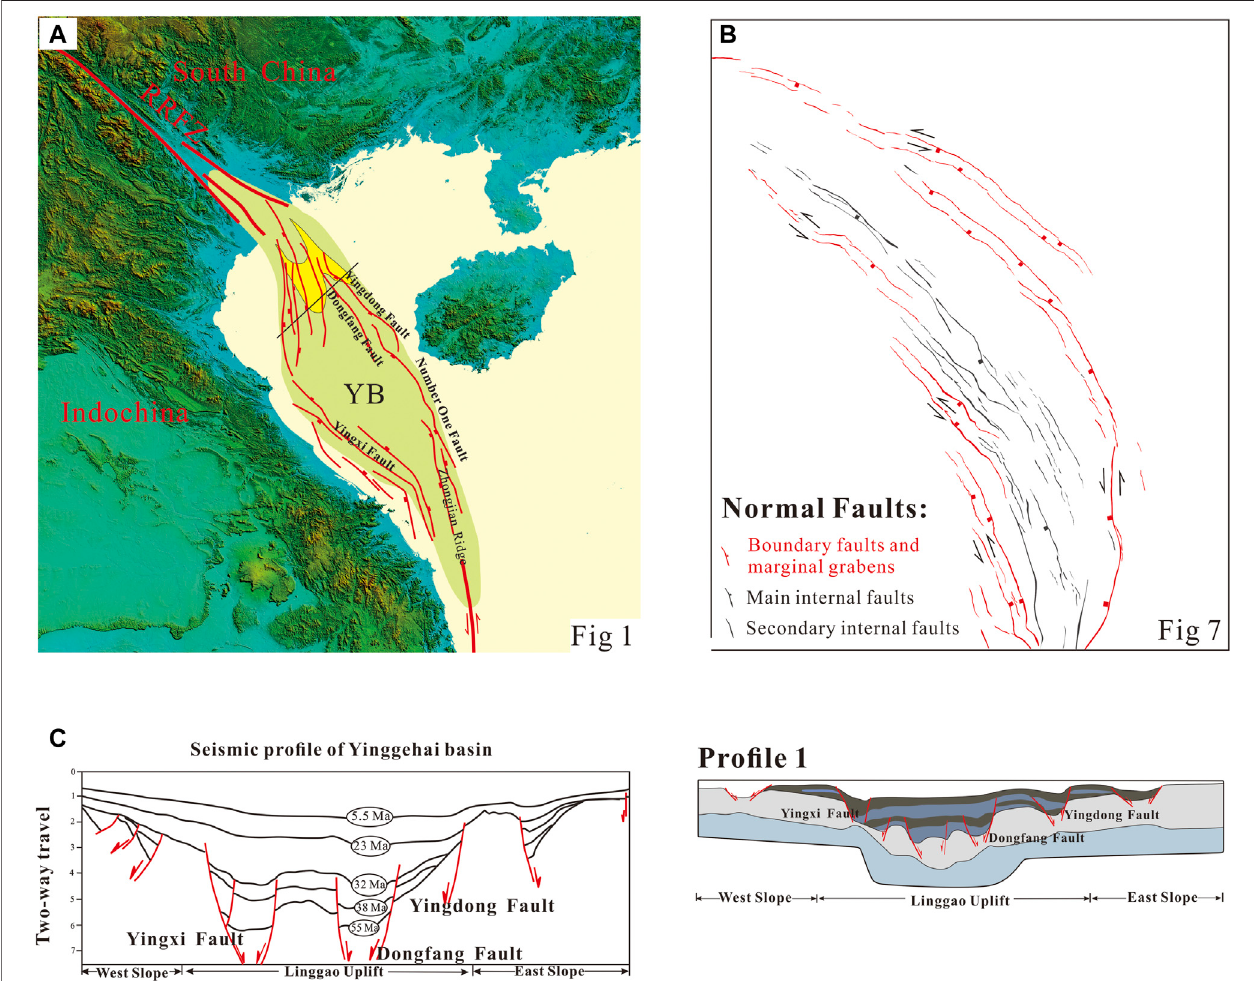
FIGURE9 | Comparison between the model results and the Yinggehai Basin: (A) primary faults of thestudy area, (B) key features of theanalog model, and (C) the comparison of the cross-sectional structure between analog modeling and seismic pro fi le (Lei et al., 2011; Lei et al., 2015).